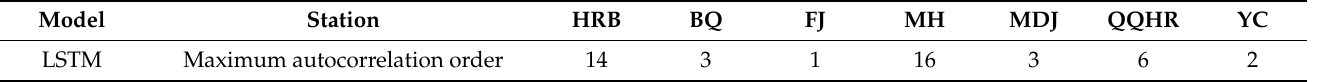
Table 2. The maximum autocorrelation order of the break-up date series at each hydrological station.